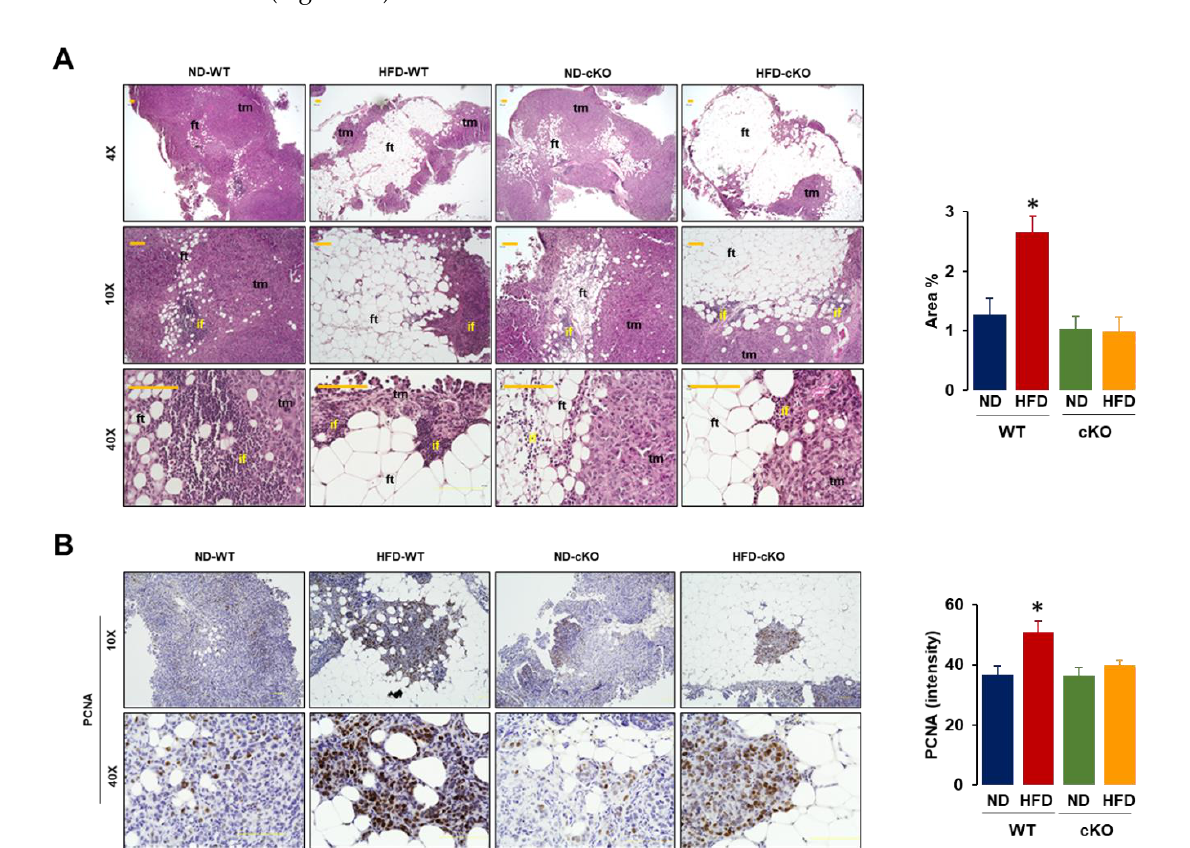
Figure 5. Histological evaluation of the omental tumor tissues in a postmenopausal diet-induced obese mouse model between CXCR2 WT and cKO mice. ( A ) Histological features of omental tumors in ND-WT, ND-cKO, HFD-WT, and HFD- cKO mice using H&E stain. tm: tumor tissue, ft: fat tissue, if: inflammatory region. Quantitative analysis of inflammatory area was performed using ImageJ with selection of inflammatory area through color threshold followed by particles analysis. ( B ) Disposition of PCNA positive cells in omental tumors from ND-WT, ND-cKO, HFD-WT, and HFD-cKO mice using immunohistochemistry. Quantitative analysis of PCNA disposition was performed using ImageJ with brown color selection through color deconvolution of hematoxylin and DAB staining followed by intensity analysis. Quantitative anal- ysis was obtained from 3 – 5 random fields of each slide (10×). * indicates a significant difference ( p ≤ 0.05) between groups as analyzed by ANOVA and Tukey’s pairwise comparison tests .